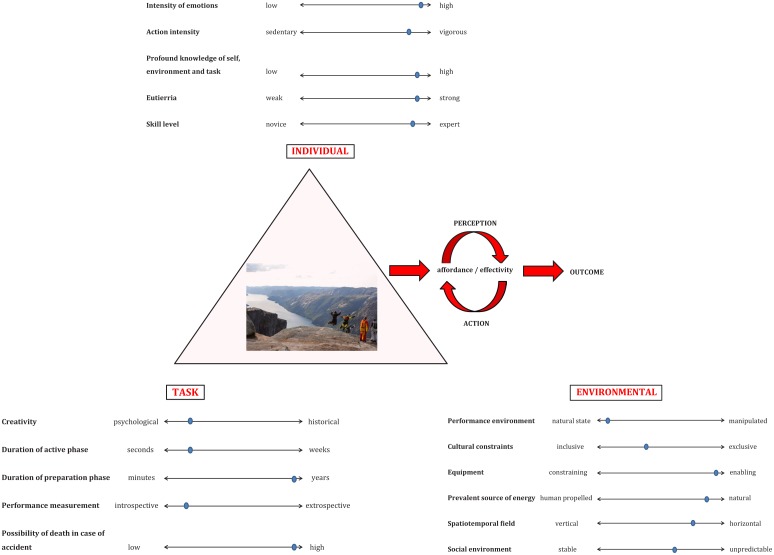
Derived from ideas of Newell (1986), Davids et al. (2008) and Immonen et al. (2017). Emerging, adaptive performer-environment relationships are scaled by situational and context-dependent key constraints that, in combination, define an extreme sport form of life/participation style. The comprehensive lens of Ecological dynamics is illustrated due to its capability to zoom into participation and engagement on multiple levels of analysis and time frames, reflecting extreme sport niches and performance outcomes as influenced and shaped by constraints from variety of levels. Due to the infinite combinations and complexity of interactions, irregular and unpredictable constraints are illustrated on continua, attending to significant situational and contextual fluctuations in each participant’s experience. To exemplify, exact positions on each continuum are depicted to illustrate the significance of each situational influencing constraint, which together as a whole consist the exemplary experience of a particular BASE jumper. For better understanding, new emerging constraints should be a posteriori included in the model according to complementary research findings and constant evolution of extreme sports. Included in the figure are constraints illustrating varying characteristics and performance environments of extreme sports in their current states of development and as reported in existing literature (e.g., Boden, 1996; Brymer and Oades, 2008; Brymer, 2009, 2010; Brymer and Gray, 2009; Thorpe, 2009; Breivik, 2011; Hristovski et al., 2011; Langseth, 2011; Varley, 2011; Albrecht, 2012; Kerr and Mackenzie, 2012, 2014; Davids et al., 2013b, 2016; Brymer and Schweitzer, 2013b, 2017; Wiersma, 2014; Yeh et al., 2015; Clough et al., 2016; Frühauf et al., 2017; Holmbom et al., 2017; Seifert et al., 2017). It is notable, that high embodied skill levels might not necessarily facilitate participation in extreme sports. Although attunement to affordances enabling behavior on the edges of one’s potential can be seen as a defining feature of the “extreme sport niche”, behaviors of individuals are subtly interconnected by multitude of interacting constraints. Image source: https://www.google.fi/search?as_st=y&tbm=isch&hl=fi&as_q=base+jumping&as_epq=&as_oq=&as_eq=&cr=&as_sitesearch=&safe=images&tbs=sur:f#imgrc=xfiYZa1hXCqt1M: